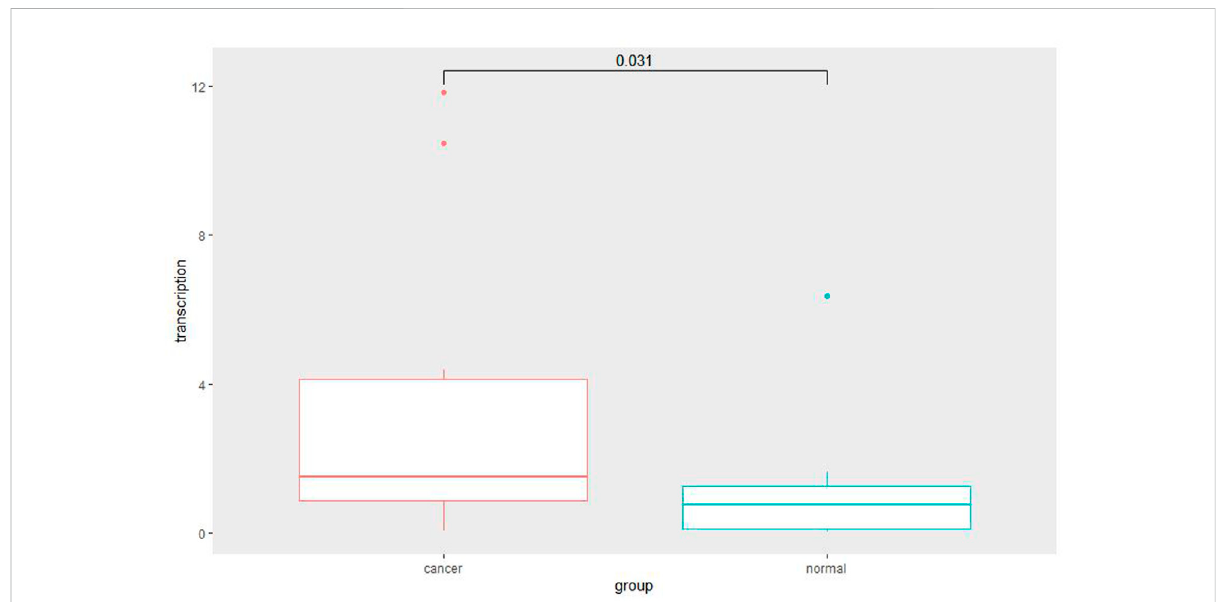
FIGURE 11 QuantitativeRT-PCRforcancerandadjacentnormalcervixtissue.QuantitativeRT-PCRassayshowedsigni fi cantlyincreased SOX9 mRNAlevel in cervical cancer tissues compared with adjacent normal cervix tissues ( p =